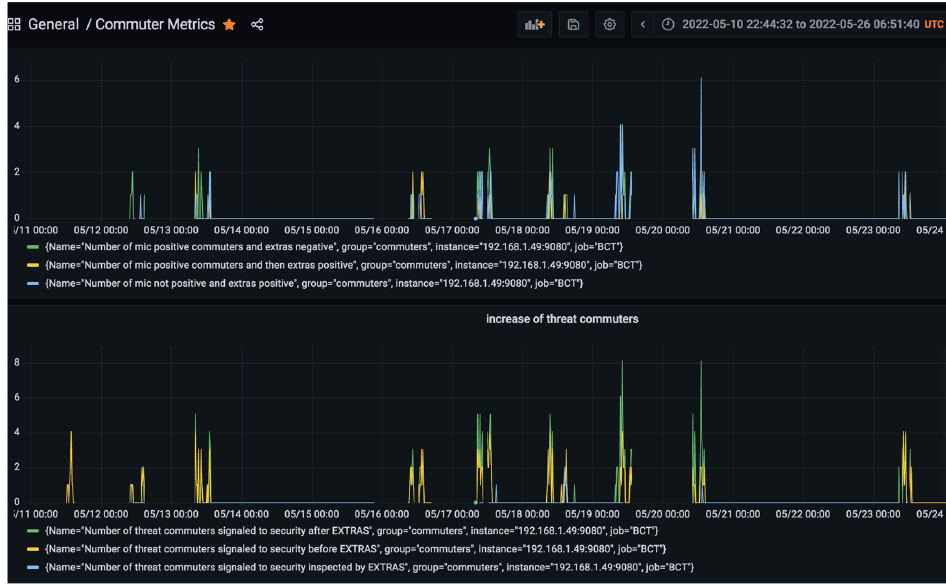
Figure 7. Grafana-based monitoring dashboard displaying aggregated metric results of the BCT days